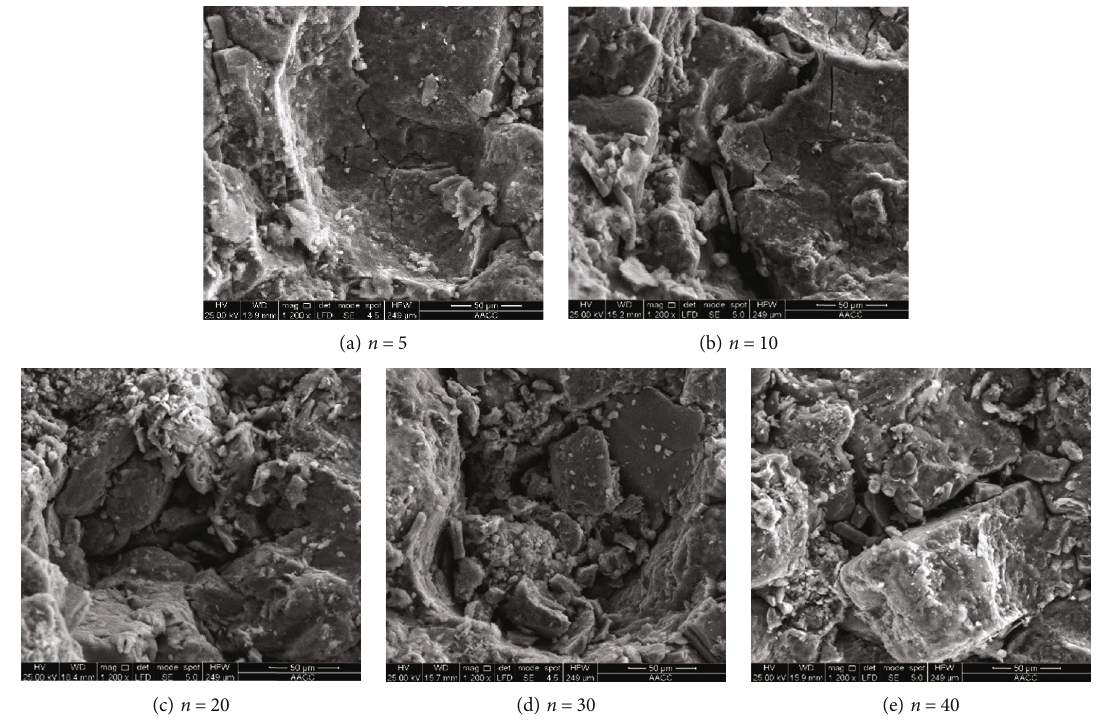
Figure 8: SEM images of micromorphology when pH = 4 : 5